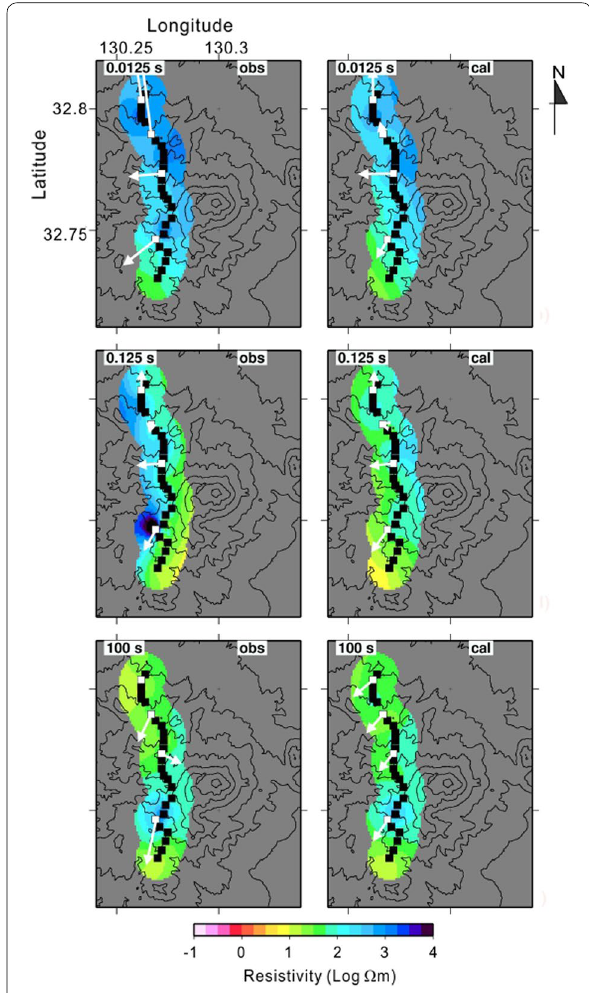
Fig. 6 Comparison of observed data (obs) with calculated responses (cal). The maps show apparent resistivity derived from Ssq impedances (Rung-Arunwan et al. 2016) and correspond to periods of 0.0125 s, 0.125 s, and 100 s. White arrows indicate the real components of induction vectors (Parkinson criteria). Details are as in Fig.